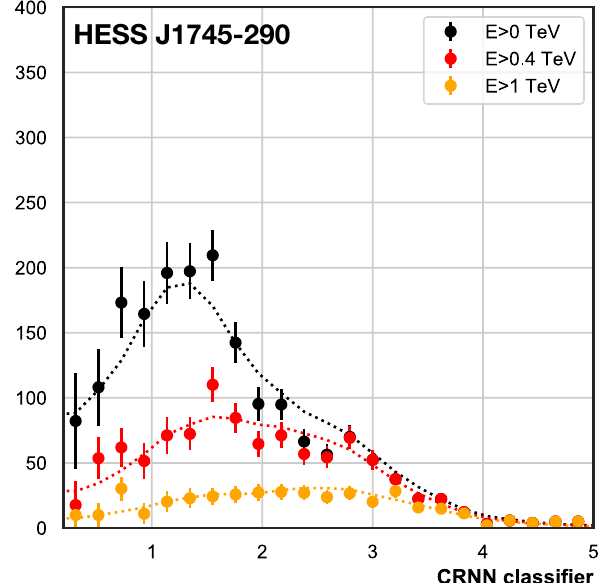
Fig. 8 Comparison of the CRNN classifier distribution with three energy thresholds obtained in the analysis of PKS2155-304 (left) and HESS J1745-290 (right), data is compared with Monte Carlo simu-